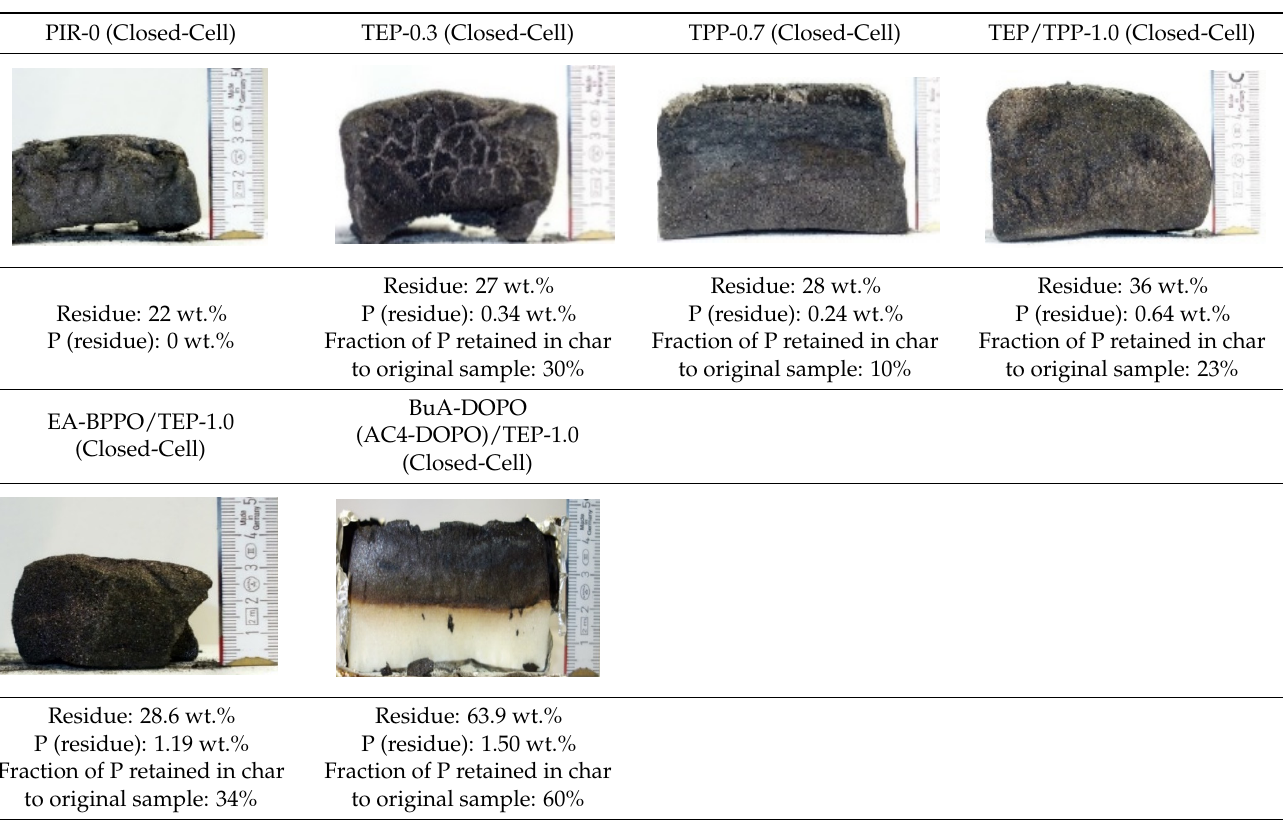
Table 9. Photographic images of the remaining sample residues after cone calorimetric investigations.